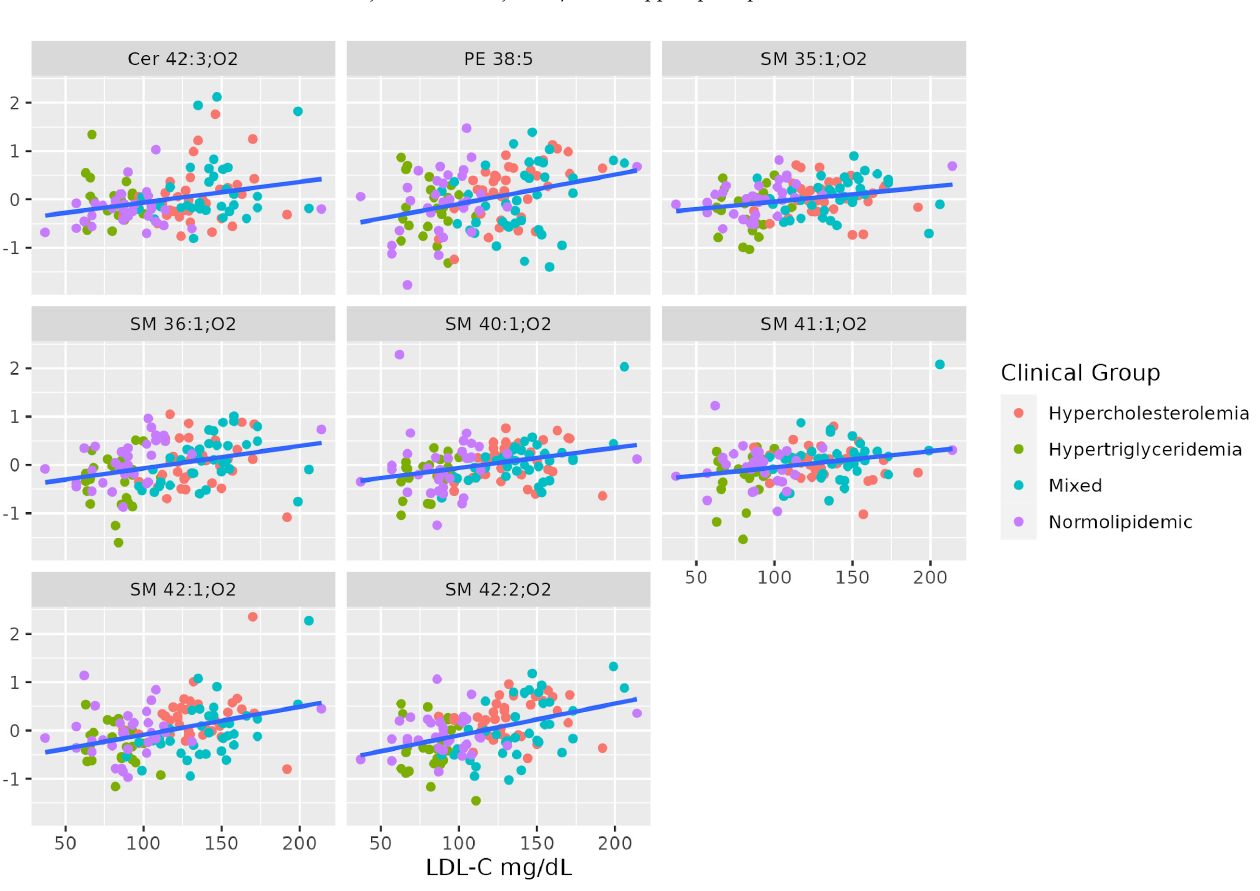
Figure 4. Dot-plot representing the correlation between serum LDL-C abundance and MS-annotated lipids. A line obtained by simple linear regression was added to aid visualization.